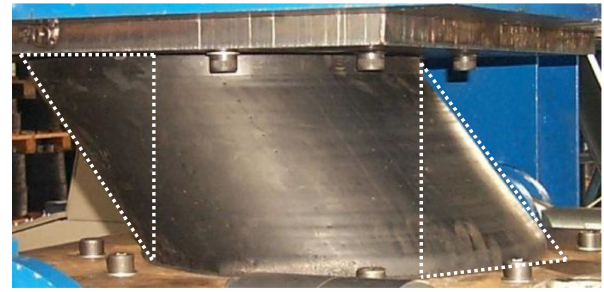
Figure 1. Cylindrical elastomeric isolator under shear